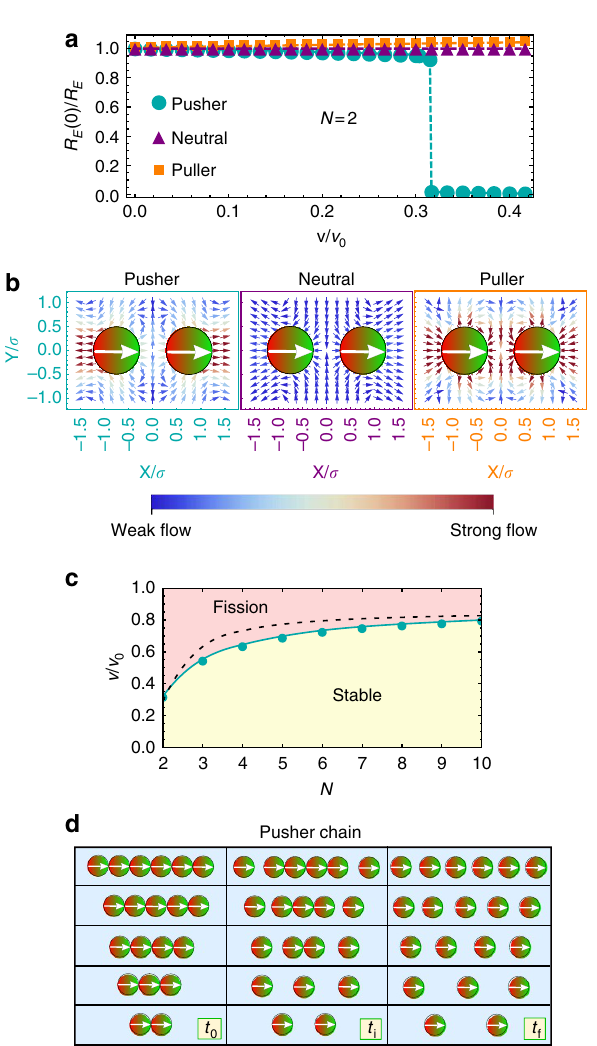
Figure 1 | Stability of microswimmer chains. ( a ) Relative end-to-end distance R E for all three HI cases and varied velocity v for fixed N ¼ 2. ( b ) Flow fields for a chain of N ¼ 2 magnetic microswimmers for (left) pushers, (middle) neutral swimmers and (right) pullers. The magnitude of the flow is indicated by the colour coding of the arrows, weak flow is indicated by dark blue and strong flow by dark red arrows. ( c ) Emerging state diagram spanned by reduced velocity v / v 0 and number N of particles within a chain of pushers marking two distinct regions; stable chains for small and fission for large self-propulsion velocities. Numerical results (cyan line) obtained for soft sphere dipoles are compared with those for hard sphere dipoles (black dashed line). ( d ) Time series indicating the fission process for the cases N ¼ 2, y , 6, showing the initial configurations at time t 0 , the configuration after the first fission event at an intermediate time t i and the final steady state configuration of N individual particles at time t f , see also Supplementary Movies 1 and